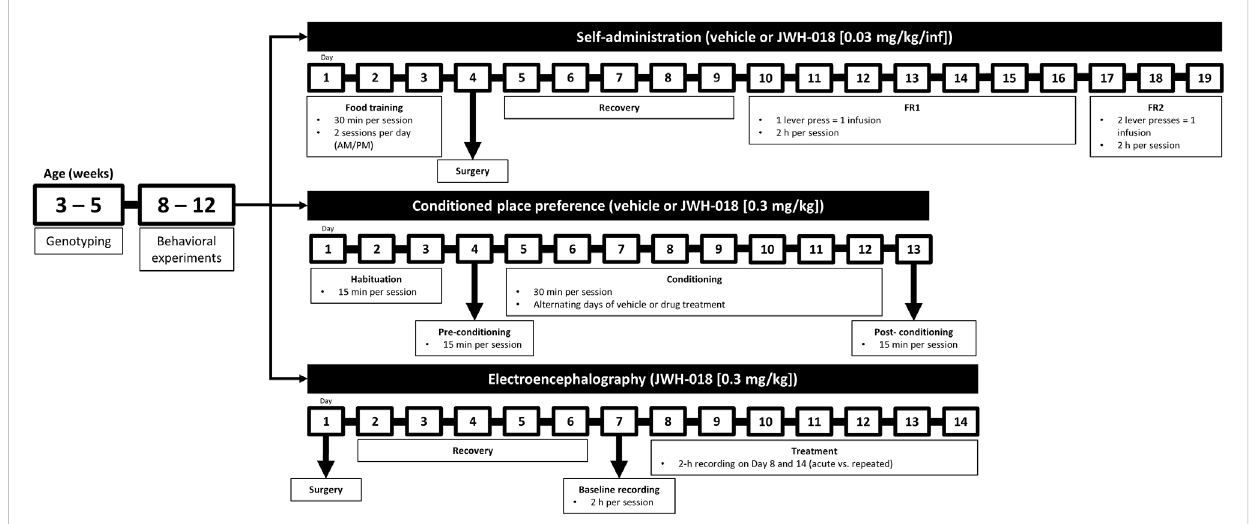
FIGURE 1 Schedule of behavioral experiments. Mice are genotyped between 3 and 5 weeks of age using tail samples. Mice are then segregated according to genotype. Starting at 8 weeks of age, only male mice are housed according to the experiment. Brains may be collected at the end of each behavioral